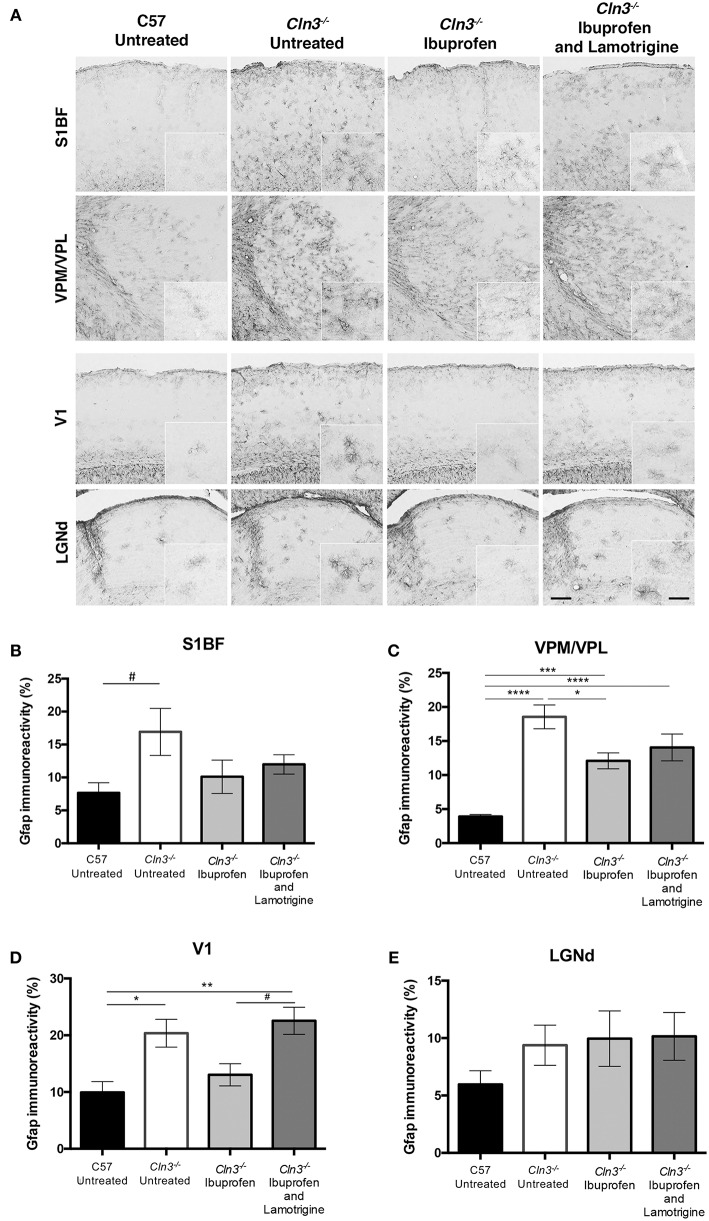
Moderate effect of Ibuprofen and Lamotrigine treatment on JNCL astrocyte immunoreactivity in 9-month old Cln3−/− mice. (A) Representative images of GFAP immunostaining in S1BF, VPM/VPL, V1, and LGNd. Scale bars, 200 and 25μm (inserts). (B–E) Quantification of % GFAP immunoreactivity in S1BF, VPM/VPL, V1, and LGNd, respectively. Data points represent mean ± S.E.M. of the % GFAP immunoreactivity. Ordinary one-way ANOVA was applied with Bonferroni's post-test (*p < 0.05, **p < 0.01, ***p < 0.001, ****p < 0.0001, and #1 < p > 0.05).